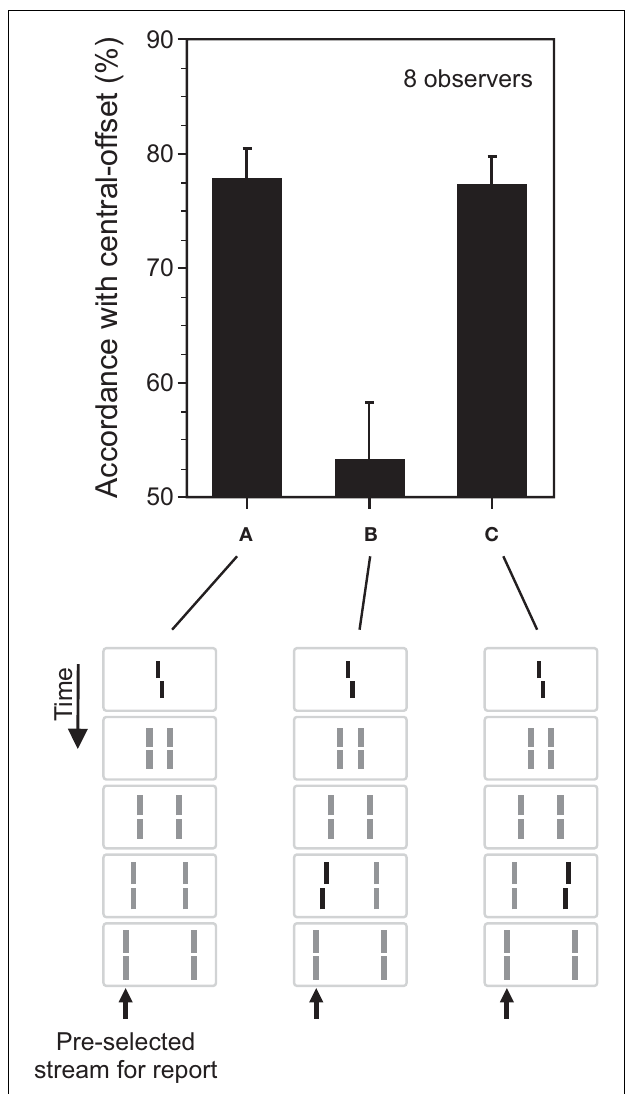
FIGURE 2 |The fate of invisible features. (A) The central line was randomly offset to the left or right (central-offset). As in Figure 1 , it was followed by non-offset, flanking lines. Observers were asked to attend to the leftward motion stream (as indicated by the arrow) and to discriminate the offset direction perceived in this motion stream. Responses were assessed with respect to their accordance with the central-offset. Although the central line was rendered invisible by sequential metacontrast, observers could discriminate the offset very well. Phenomenologically, only one moving line with one vernier offset is perceived. (B) We added a second offset to the penultimate line in the attended motion stream.When the vernier and line offsets were in opposite directions, offsets canceled out each other indicating a combination of the two offsets. (C) Performance, compared to (A) , is virtually not changed when the second offset is added to the penultimate line in the unattended motion (lines with offsets are highlighted in black for graphical sake; all lines had the same luminance in the experiments; Copyright ©2006 ARVO. Adapted from Otto et al. (2006).